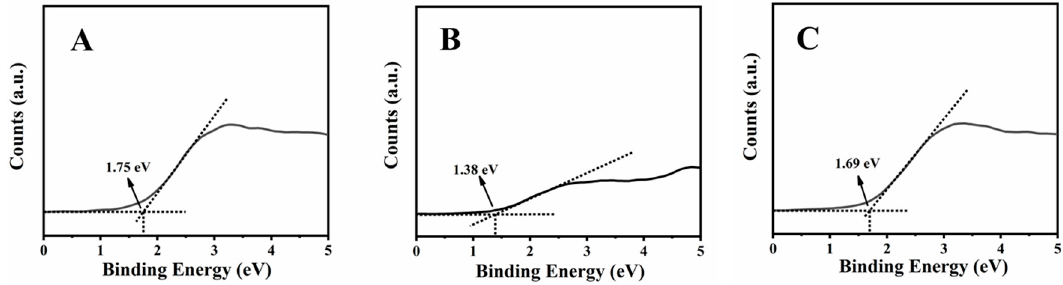
Figure 8. XPS valences of 2D ZIS ( A ), 2D ZIS-S v ( B ), and multilayer 2D ZIS ( C ).